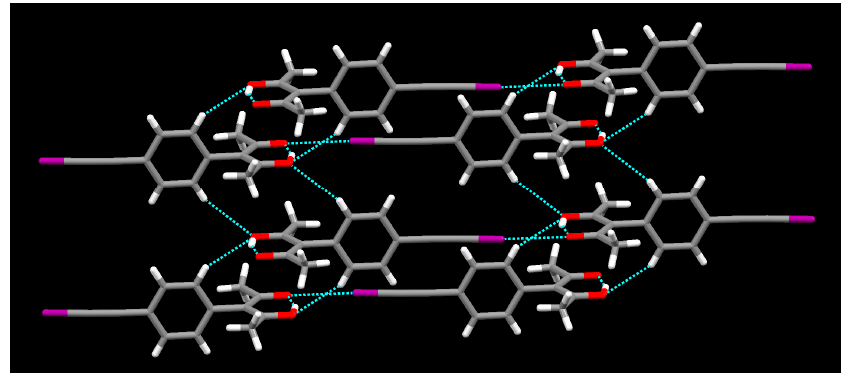
Figure 3. Part of the crystal structure of L3 (color codes: red—oxygen; purple—iodine). The intramolecular X-C ≡ C bond angles in L2 and L3 deviate slightly from linear at 174.14° and 172.44°, respectively. As expected, the C-X···O halogen-bond angle is more linear for the C-I···O bond (178.0°) than for the C-Br···O bond (170.8°). Again, the torsion angle which describes the orientation